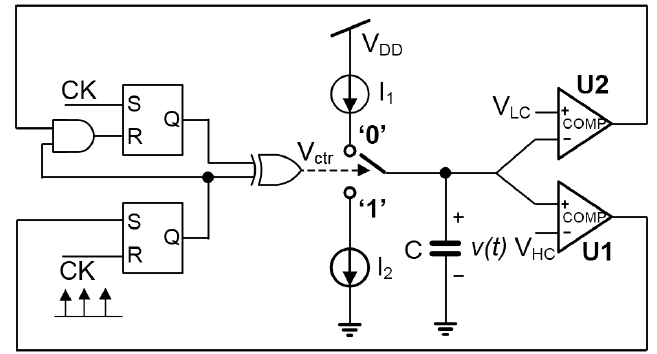
Figure 3. Simplified block diagram of the proposed N-shaped chaos generator.